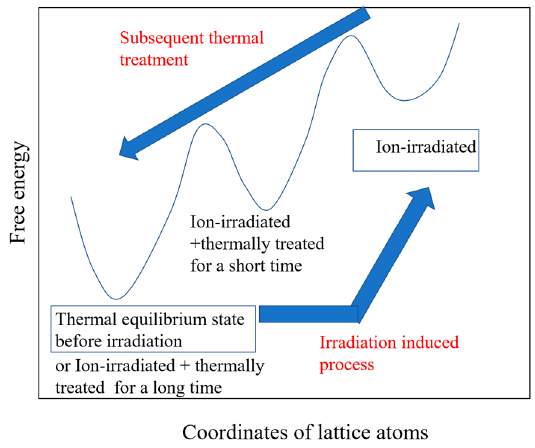
Figure 31. Schematic diagram of change in free energy for “irradiation-induced process” and subsequent thermal annealing.